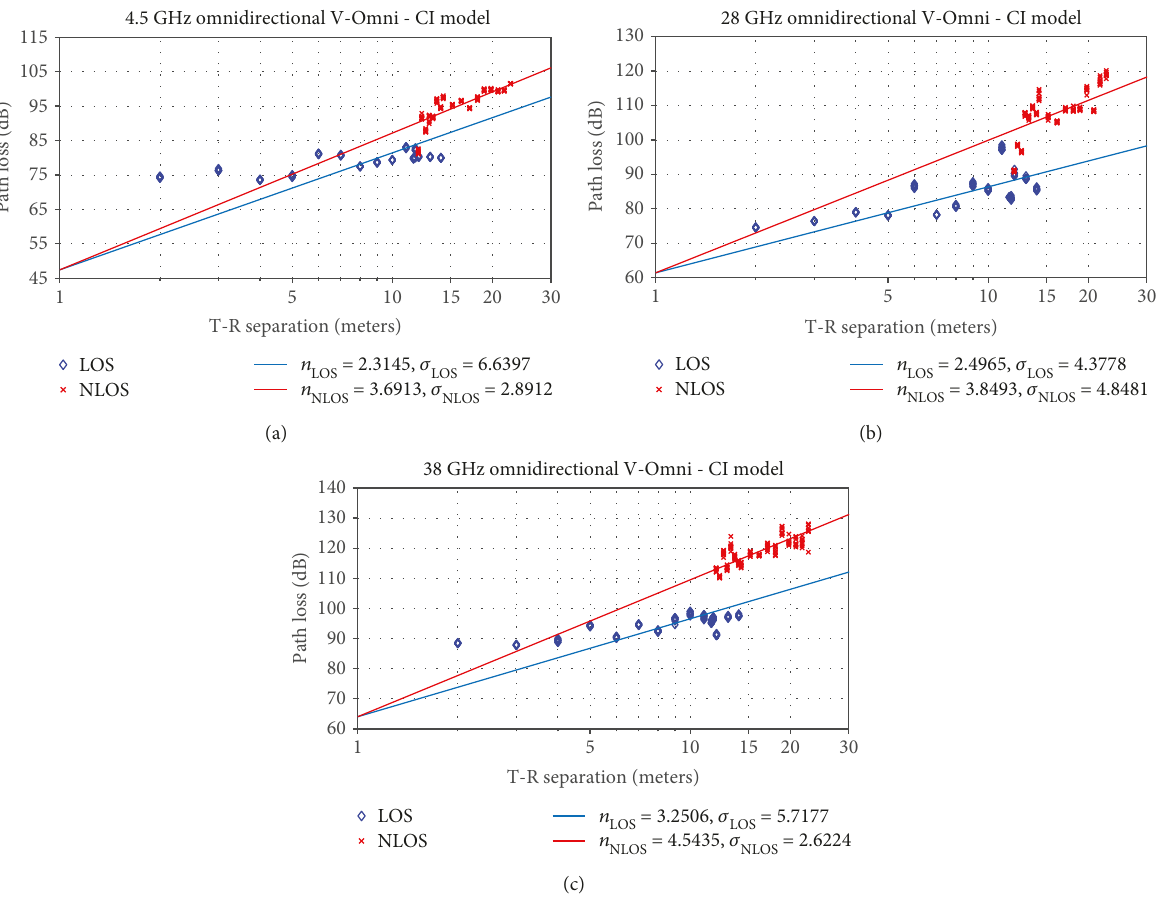
Figure 4: CI path loss model for omnidirectional V-Omni for LOS and NLOS (a) 4.5GHz, (b) 28GHz, and (c) 38 GHz. Table 2: CI path loss model parameters for LOS and NLOS, at 4.5GHz, 28GHz, and